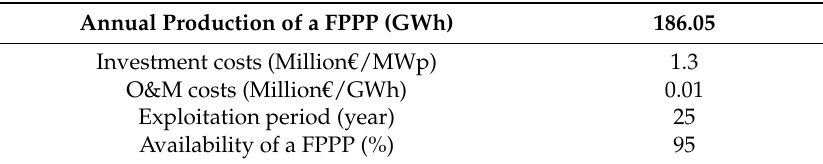
Table 5. Estimated input parameters for the calculation of